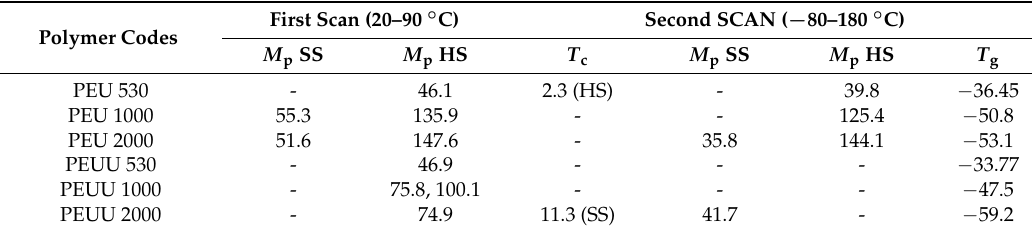
Table 2. DSC results of synthesized polymers.